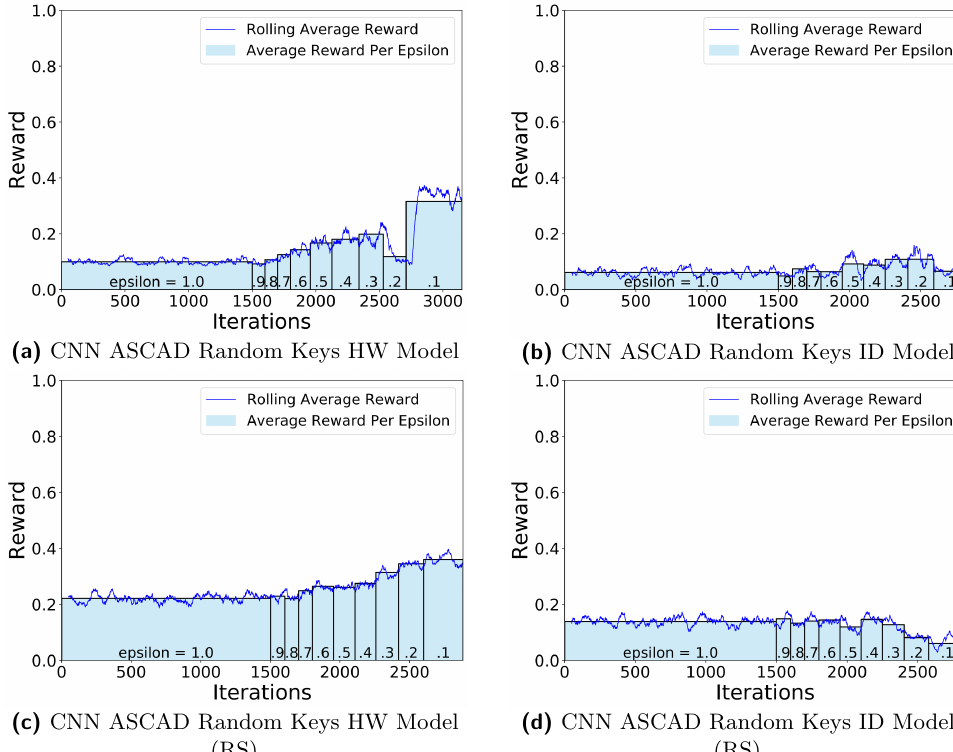
Figure 9: An overview of the Q-Learning performance for the ASCAD with random key dataset Experiments. The blue line indicates the rolling average of the Q-Learning reward for 50 iterations, where at each iteration, we generate and evaluate a neural network architecture. The bars in the graph indicate the average Q-Learning reward for all neural network architectures generated during that ε .